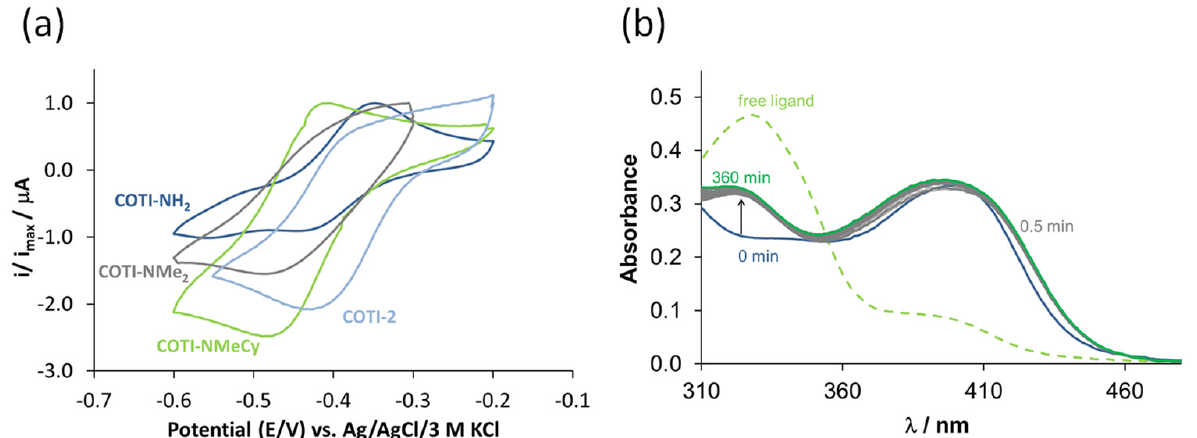
Figure 5. Cyclic voltammetry and interaction with GSH for copper(II)–thiosemicarbazone complexes. ( a ) Normalized cyclic voltammograms of the copper(II)–thiosemicarbazone (1:1) systems at a 0.01 V/s scan rate. c L =1 mM, c Cu = 1 mM, pH = 7.40 (10 mM HEPES), T = 25 °C, I = 0.1 M tetrabutylammonium nitrate, and 90% ( v/v ) DMSO/H 2 O. ( b ) Time-dependent changes in the UV-vis absorption spectra of the copper(II)–COTI-NMe 2 (1:1) system in the presence of 300 equiv. GSH (solid lines) at pH 7.4 in 5% ( v/v ) DMSO/H 2 O under argon and the spectrum of the free ligand (dashed line). c L = c Cu(II) = 30 µM, c GSH = 9 mM, T = 25 °C, I = 0.1 M (KCl), and ℓ = 1.0 cm.